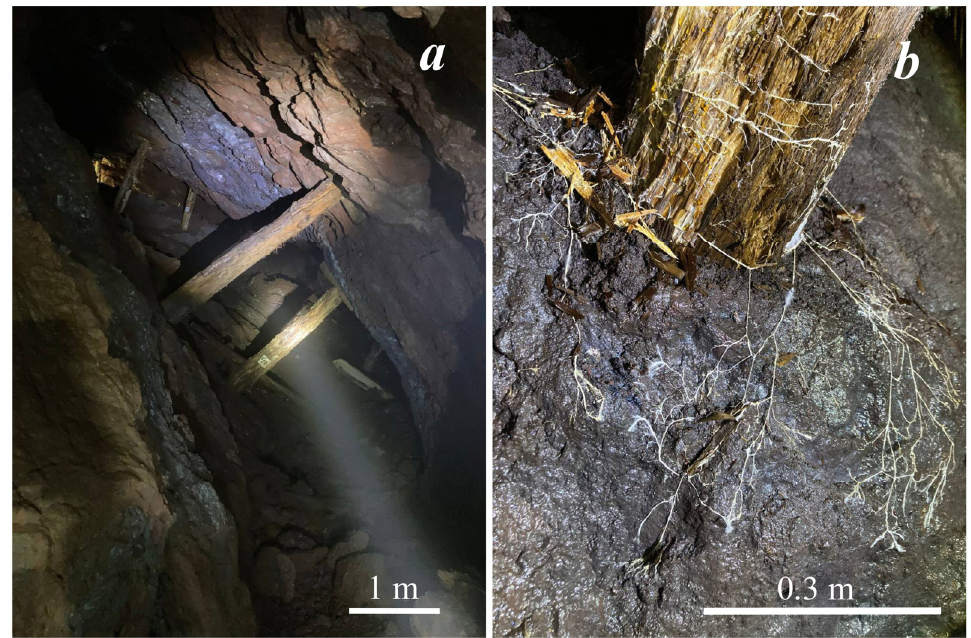
Figure 1. Sampling sites: ( a ) general view of the abandoned Rogoselga adit, ( b ) brown rot fungi cords on a damaged wood and carbonate rock.